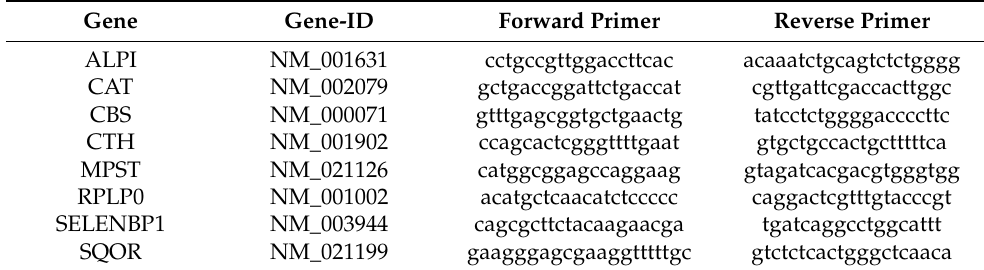
Table 1. Primers (5 (cid:48) –3 (cid:48) ) used for qRT-PCR analyses.